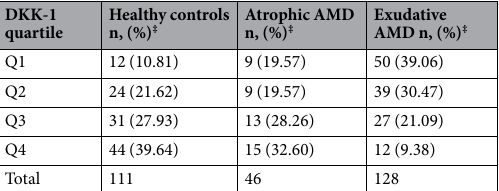
Table 3. Frequencies of Study Subjects According to the DKK-1 Quartile Group. DKK-1 = dickkopf-1; AMD = age-related macular degeneration. Q1, < 393.79; Q2, 393.80~527.73; Q3, 527.74~737.18, and Q4 > 737.19 pg/mL. ‡ % of total in quartile. Values were expressed as the number (%); Chi-square test for trend; χ 2 = 71.25, P <